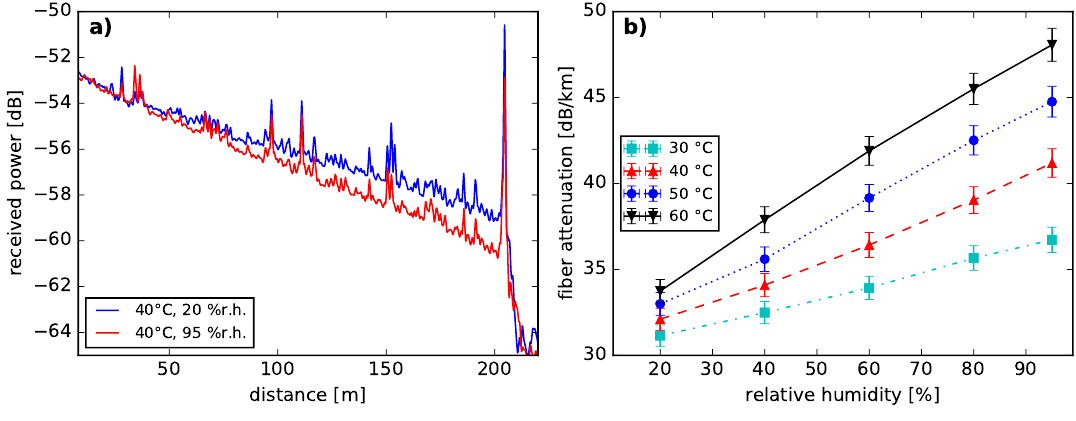
Figure 2. ( a ) Measured Rayleigh backscatter trace at 40 ◦ C and 20 % r.h., 95 % r.h., respectively. ( b ) Fiber attenuation from backscatter power change as a function of relative humidity at given temperatures and a wavelength of 1306 nm. The error bars mark the threefold standard deviation from the linear regression applied on all measured data